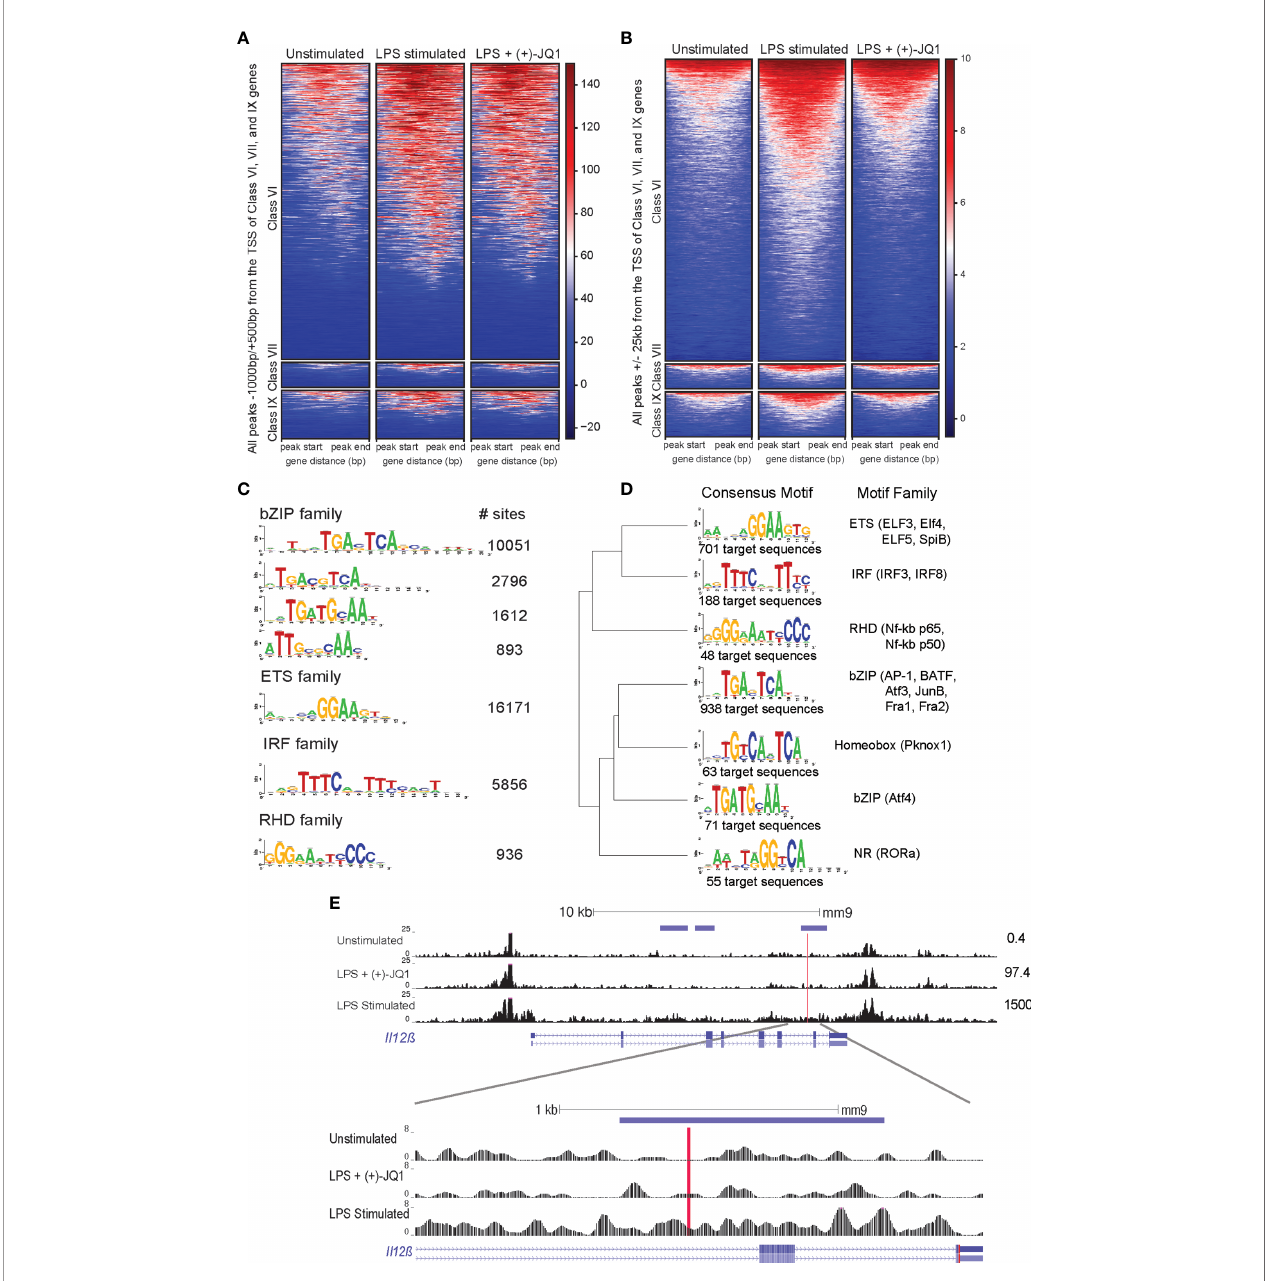
FIGURE 3 | (+)-JQ1 prevents LPS-induced chromatin remodeling at putative AP-1 and IRF regulatory elements associated with class VI genes. Heatmaps of accessible chromatin during unstimulated (left), LPS stimulated (center) or LPS + (+)-JQ1 (right) conditions for Classes VI (top), VII (center), and IX (bottom) for ChIPSeeker identi fi ed (A) promoter regions and (B) distal regions. (C) Identi fi cation and quanti fi cation of sites containing known HOMER motifs for regions that increase in accessibility with LPS stimulation as compared with unstimulated, untreated BMDMs (FDR < 0.05 for differential analysis, FDR < 0.10 for motif enrichment). (D) Identi fi cation, motif clustering, and quanti fi cation of sites containing known HOMER motifs for regions that decrease in accessibility with (+)-JQ1 treatment prior to LPS stimulation as compared with LPS stimulation alone (FDR < 0.05 for differential analysis, FDR < 0.10 for motif enrichment). (E) Gene tracks of ATAC-seq peaks within 25kb of the transcription start site of Il12 b for unstimulated (top), LPS + (+)-JQ1 (center) and LPS stimulated (bottom) conditions. Horizontal purple bars above the tracks are representative of peaks that are differentially increased during LPS stimulation compared with unstimulated BMDMs and are differentially decreased with (+)-JQ1 as compared with LPS alone (FDR < 0.05). Red line is representative of putative AP-1 motif identi fi ed by HOMER. Numbers to the right represent corresponding Il12 b transcript levels. FDR adjusted P values for differential analysis determined using DESeq2 and for motifs using HOMER. N = 3 biological